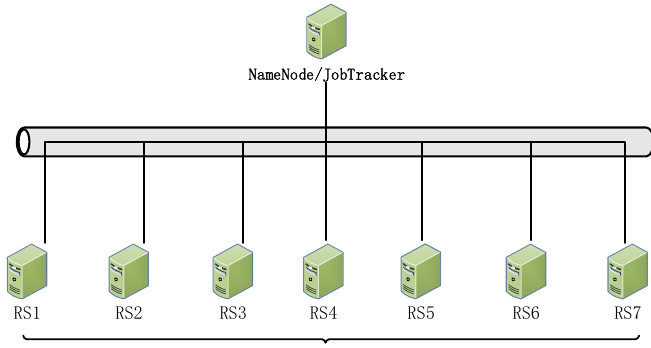
Figure 14. NoSQL cluster-based tile processing architecture.